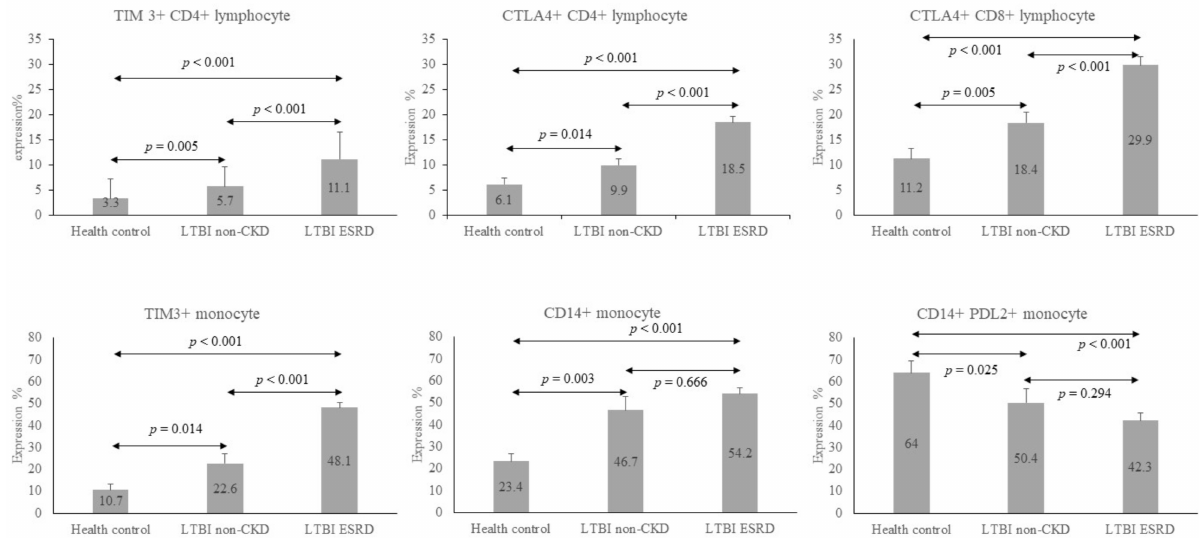
Figure 1. Bar chart to illustrate the expression status of selected immune checkpoints and CD14+ monocytes of health control (HC), LTBI-non-CKD, and LTBI-ESRD. The number in the bars were the mean and the error lines represented mean of standard deviation. ↔ meant comparison of two groups. Only the percentages of TIM3 and CTLA-4 expression on CD4+ cells (TIM3+CD4+ and CTLA-4+CD4+), CTLA-4+CD8+, and TIM3+ monocytes were significantly higher in the LTBI-ESRD group than in the LTBI-non-CKD group. They also were significantly higher in LTBI-non-CKD than HC. CD14+ expression of monocyte was significantly higher in HC than LTBI-non-CKD, but not in LTBI-ESRD. On the contrast, PDL2+ CD14 expression of monocytes were significantly higher in LTBI-non-CKD, compared to HC. The data between various groups were compared by Mann–Whitney U